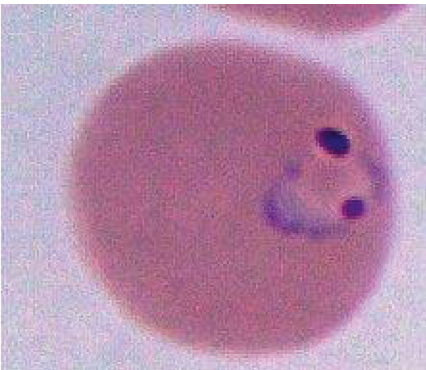
Figure 1: Enlarged picture of a ring-form trophozoite of Plas- modium falciparum .